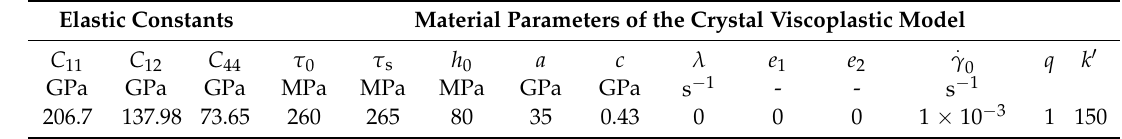
Table 6. Elastic constants and crystal plasticity parameters of the GH4169 superalloy [54]. Elastic Constants Material Parameters of the Crystal Viscoplastic Model